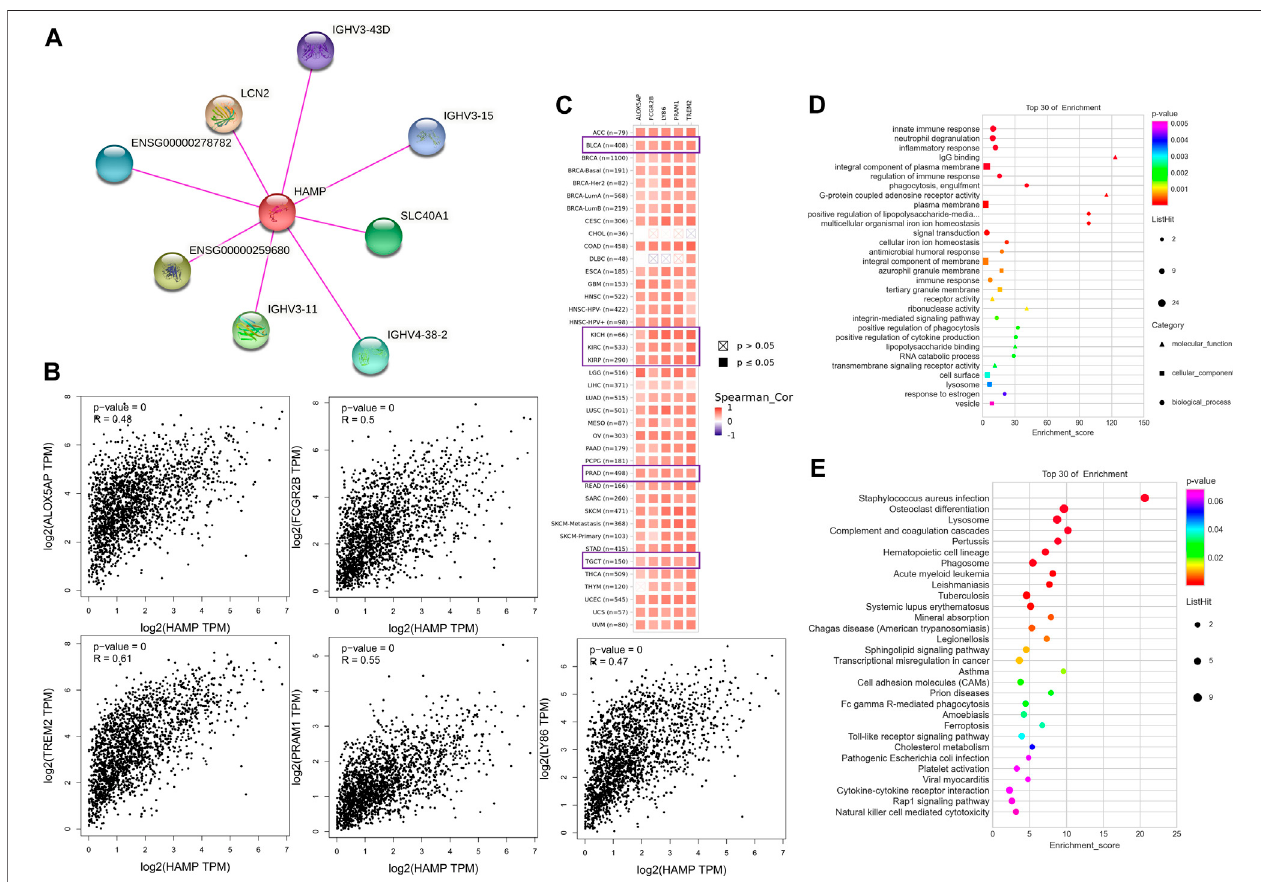
FIGURE 7 | Hepcidin-associated gene enrichment analysis. (A) hepcidin-binding proteins analyzed by STRING. (B) Correlations between hepcidin and hepcidin- associated genes in TCGA analyzed by GEPIA2. (C) Heatmap of corresponding correlation results in different types of cancers. (D) Gene ontology (GO) and (E) Kyoto encyclopedia of genes and genomes (KEGG) enrichment